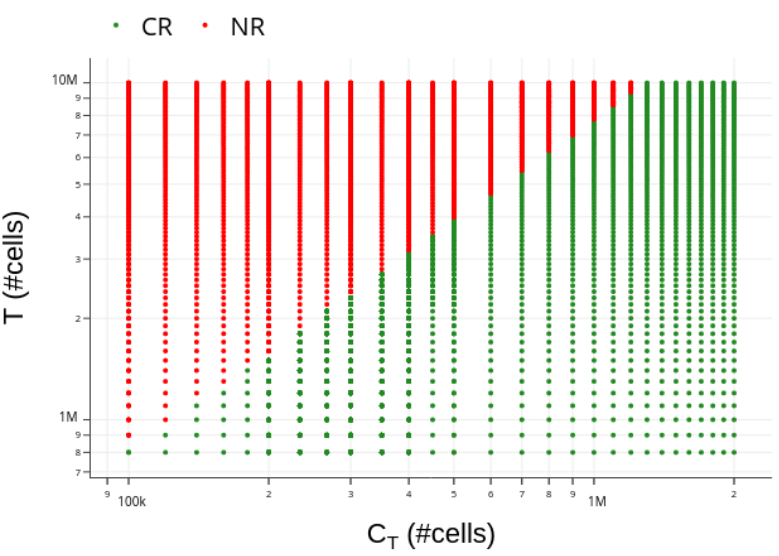
Figure 5. Diagram of occurrence of complete response (CR: T ( 300 ) non-response (NR: T ( 300 ) 1 10 10 cells, red dots) for the HDLM-2 + CAR-T 123 scenario. T is the ≥ × initial tumor burden, and C T is the CAR-T 123 cell dose injected on day 42. The usual ranges of T and C T were considered, with the number of tumor cells starting at the detectable limit established in [7] and with the maximum CAR-T cell dose corresponding to the highest value used in [7]. Higher doses ( C T 1.3 10 6 cells) are able to eliminate any tumor burden smaller than 10 7 cells. It is worth ≥ × noting that the CR region decreases with the increase in T